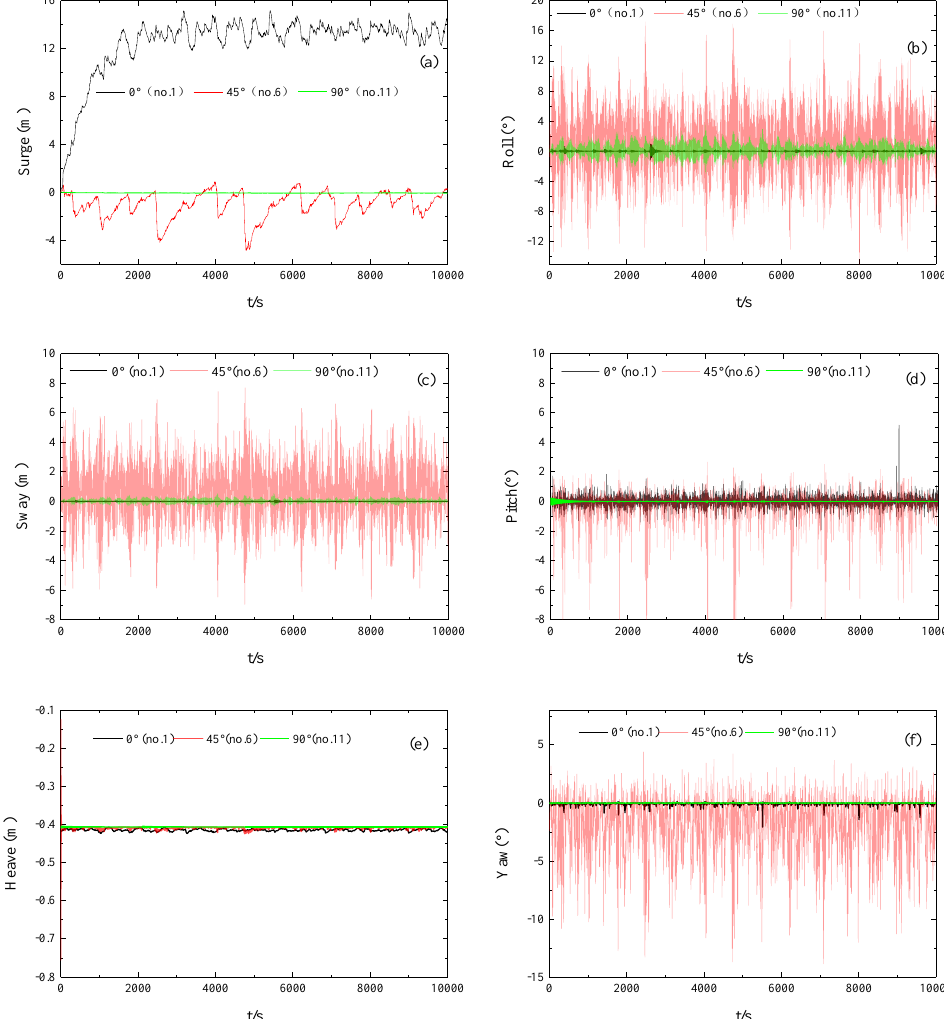
Figure 19. 6DoF time-history motion curves different wave angles on the float. (Sub-figures: ( a ) surge motion curves; ( b ) roll motion curves; ( c ) sway motion curves; ( d ) pitch motion curves; ( e ) heave motion curves; ( f ) yaw motion curves).